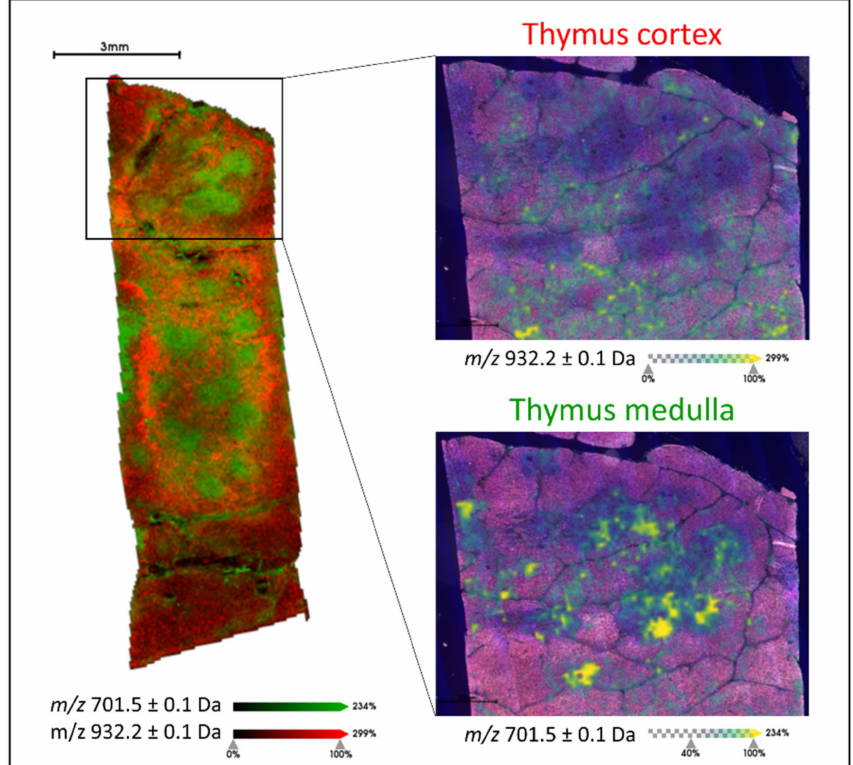
Figure 1. Example MALDI-MS image overlay of m / z 701.5 [PA(18:0/18:1)] (green) and m / z 932.2 (red) which are localised to the medulla and cortex regions of the thymus, respectively. The two insets present the individual ion images (green to yellow scale) overlaid with the haematoxylin and eosin (H&E) stained image of the tissue section, with the cortex and medulla characterised by the lighter and darker regions, respectively. Intensity and scale bars are